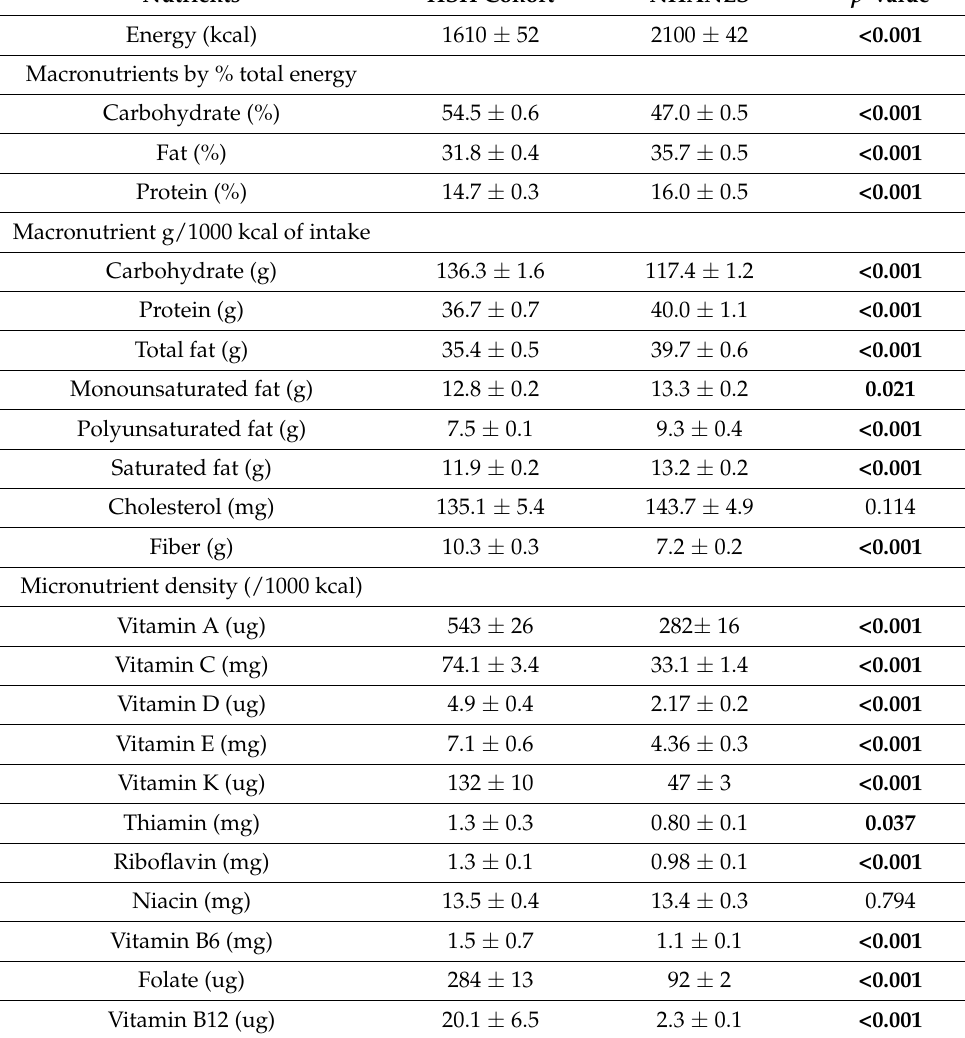
Table 2. Daily mean macronutrient intake as percent energy intake, and macronutrient and micronu- trient density per 1000 kcal in HSH and NHANES.